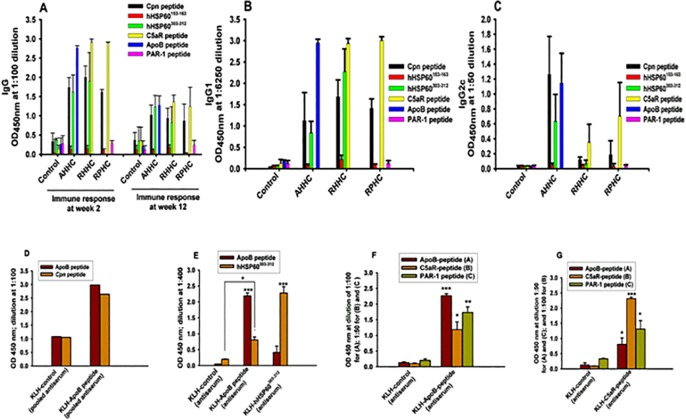
Levels of constructed protein-induced IgG, IgG1, and IgG2c antibodies in the sera of B6;129S-Ldlr
tm1Her
Apob
tm2Sgy
/J mice at 2 weeks and 12 weeks respectively, after the first immunization and in controls (GST-Den-immunized mice).The mean optical densities (ODs) and SEM obtained from plasma samples of constructs AHHC, RHHC, and RPHC-immunized mice on Cpn peptide (C)-, hHSP60153-163 (H)-, hHSP60303-312 (H)-, C5aR-peptide (R)-, ApoB peptide (A)-, PAR-1(P)-coated ELISA plates are shown. (A) IgG at the dilution ratio: 1:100. (B) IgG1 at the dilution ratio: 1:6250. (C) IgG2c at the dilution ratio: 1:50. (D) Cross reaction between human ApoB peptide-induced antiserum and Cpn peptide. (E) Cross reaction between human ApoB peptide- and hHSP60303-312 peptide-induced antiserum and their antigens. (F) Cross reaction between ApoB peptide-induced antiserum and antigens of either PAR-1 peptide or C5aR peptide. (G) Cross reaction between C5aR peptide-induced antiserum and antigens of either ApoB peptide or PAR-1 peptide. Antiserum used for cross-reaction was taken at week 8.